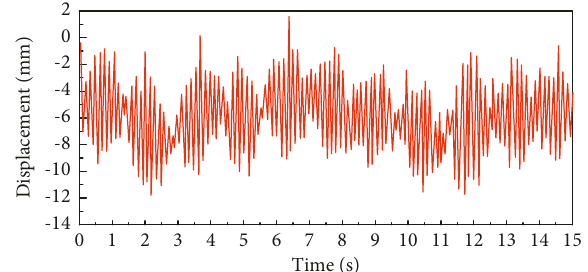
Figure 14: Deflection curve of trestle truss at observation point 1.